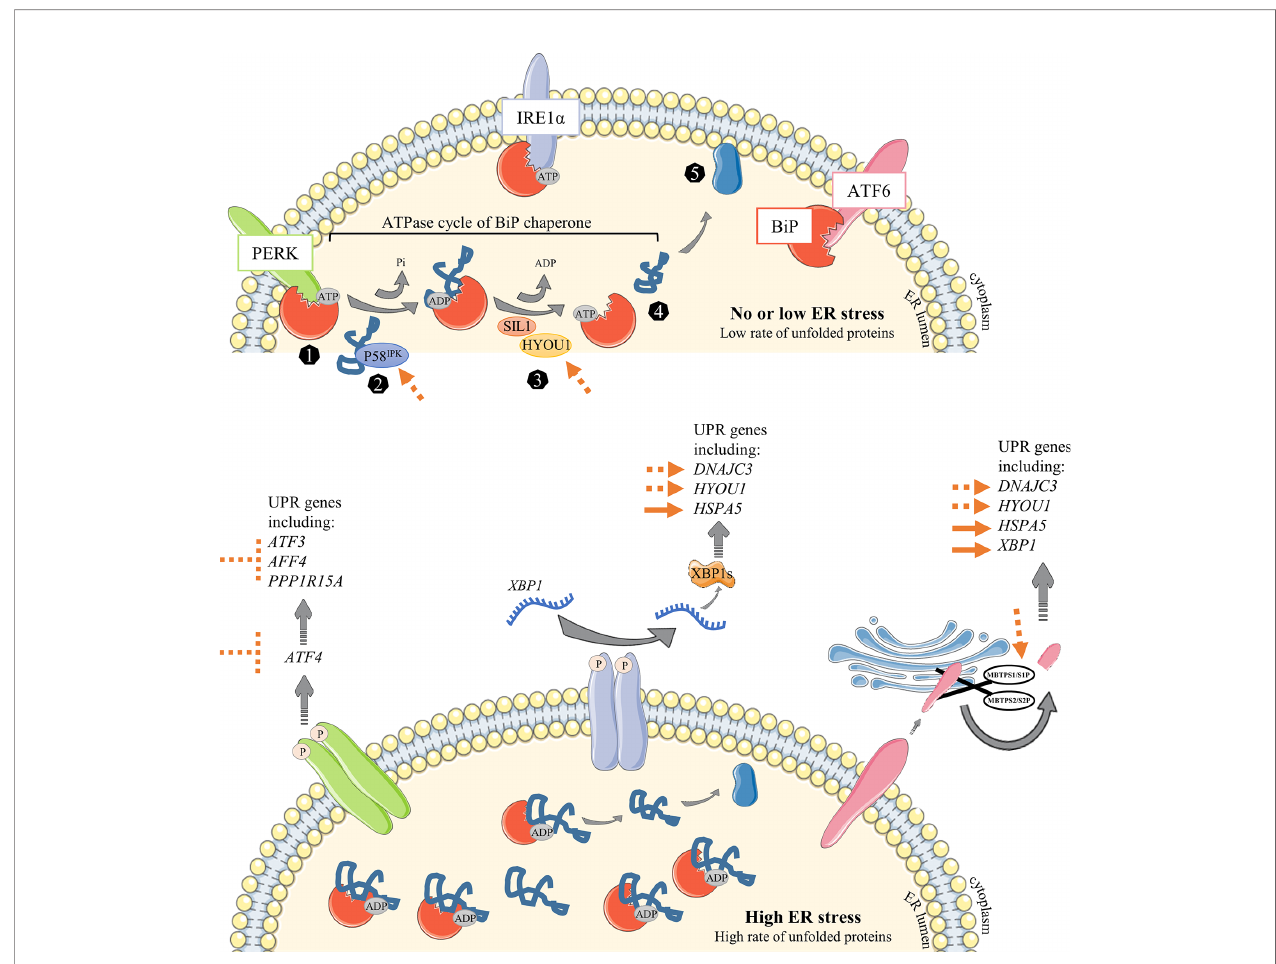
FIGURE 5 | Overview of known or suggested strategies to improve Ig production in CHO cells. In the fi rst steps of NBC activation, a low rate of proteins is processed into the ER leading to no or negligible stress conditions (upper panel). When cells undergo the following steps of differentiation that will result in the generation of highly-producing secreted Ig PBs/PCs, mass of their ER is getting bigger and associated with an important stress. Unfolded Protein Response is then engaged to cope with the increasing amount of proteins in the ER. (1) The ER-resident chaperone BiP binds to unfolded and misfolded proteins and consequently releases the sequestrated IRE1 a , PERK and ATF6 ER sensors, leading to their activation following (i) dimerization and auto-phosphorylation of IRE1 a and PERK elements or (ii) MBTPS1 /S1P and MBTPS2 /S2P – mediated cleavage of ATF6 a in the Golgi apparatus. (2) DnaJ family members such as P58 IPK (encoded by DNAJC3 ) bind directly to unfolded and misfolded proteins to guide their transfer onto an ATP-bound BiP. Given the ATPase activity of BiP, an inorganic phosphate (Pi) is instantly released from BiP, leading to a conformational modi fi cation which stabilizes protein into the ADP-bound BiP (3). Thereafter, nucleotide-exchange factors (NEFs) such as SIL1 and HYOU1 facilitate the release of ADP from BiP and the rebinding of ATP. 4-5) As a consequence, client is released and then processed to be secreted outside of the cell. The main strategies already proposed to improve Ig production in CHO cells are represented as full orange arrows. The strategies discussed in this review are represented as repressive or permissive dotted orange